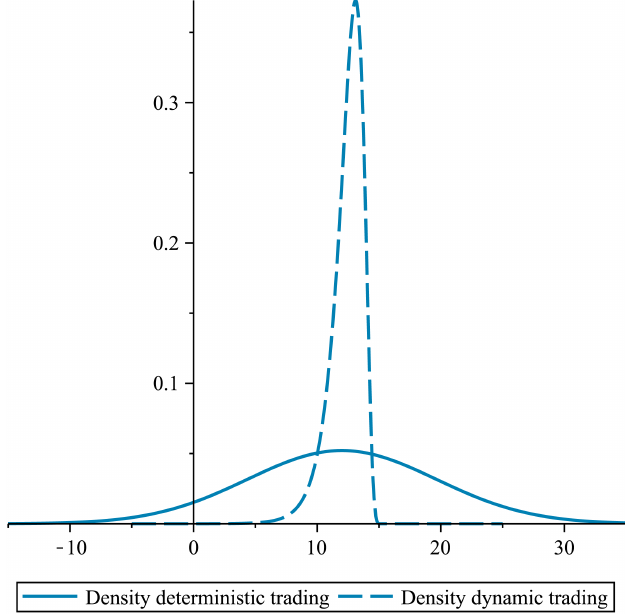
Figure 1. Densities of the optimal terminal wealth for (MVD) and